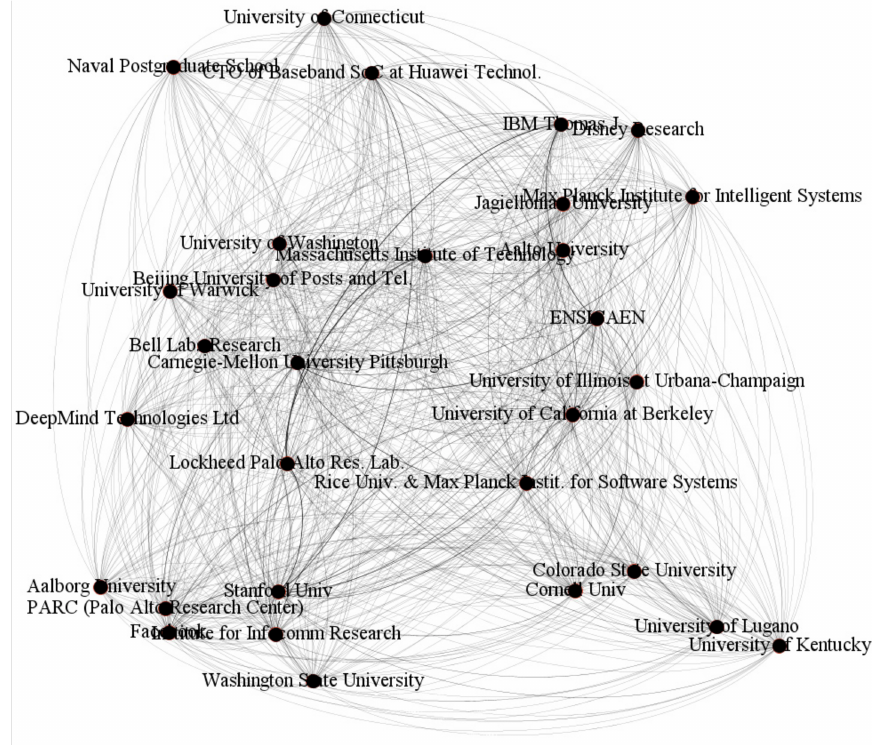
Figure 1. Graph of citations of scientific publications for 30 selected collective